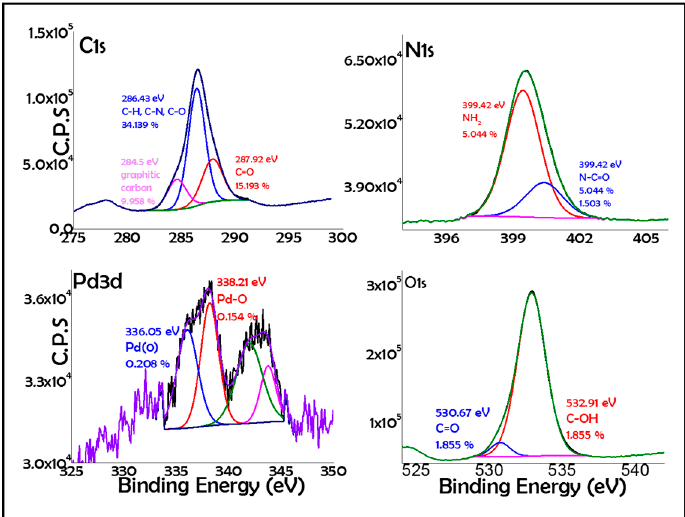
Figure 3. High resolution X-Ray Photoelectron Spectroscopy (XPS) peaks and their best deconvolution to individual components indicated for each of the elements present in Pd/CS-GO2.